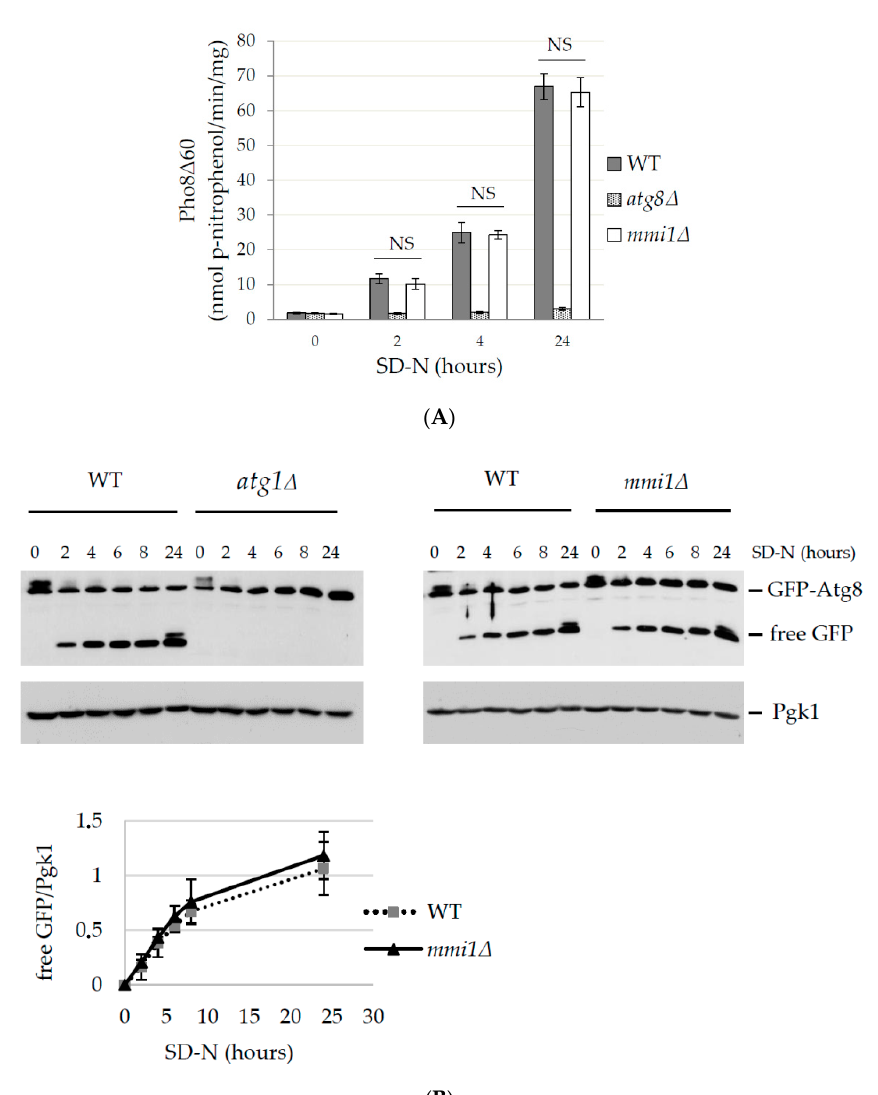
Figure 1. Basal and nitrogen starvation-induced autophagy normally occur in mmi1 Δ cells. ( A ) Exponentially growing WT, atg8 Δ , and mmi1 Δ cells expressing Pho8 Δ 60 (OD 600 ≈ 0.8) were shifted to nitrogen starvation medium (SD-N). Samples were taken in indicated time points, proteins extracted, and the specific Pho8 Δ 60 activity was determined. Results are means ± SD of three independent experiments performed in duplicates (n = 6). The statistical evaluation was performed by using two way analysis of variance (ANOVA). The threshold for significance was set as p ≤ 0.01. NS; not significant; ( B ) Western blot detection of GFP-Atg8 cleavage in the WT, atg1 Δ , and mmi1 Δ cells. Cells expressing GFP-Atg8 were grown until the logarithmic growth phase (OD 600 ≈ 0.8) and then shifted to the SD-N medium. Samples were taken at indicated time points and the cleavage of GFP-Atg8 was analyzed by Western blot detection with antibodies against GFP. Detection of Pgk1 was used as a loading control. Quantification of the blots is presented below. GFP ratio (free GFP/Pgk1) was calculated. Error bars reflect SD from the two independent experiments.